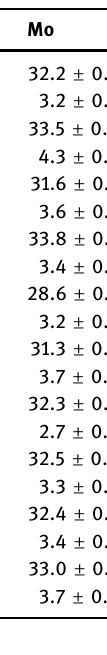
Table 2: Chemical composition of the μ phase and FCC phase in the as - sintered and as - annealed alloys ( at% )